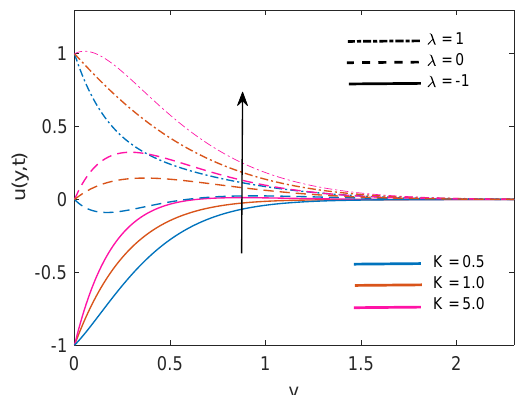
Figure 5. Variation in velocity profile for different K when Nr = 1.5, Gr = 5, Q = 0.5, M 2 = 5, φ = 0.1 and t =